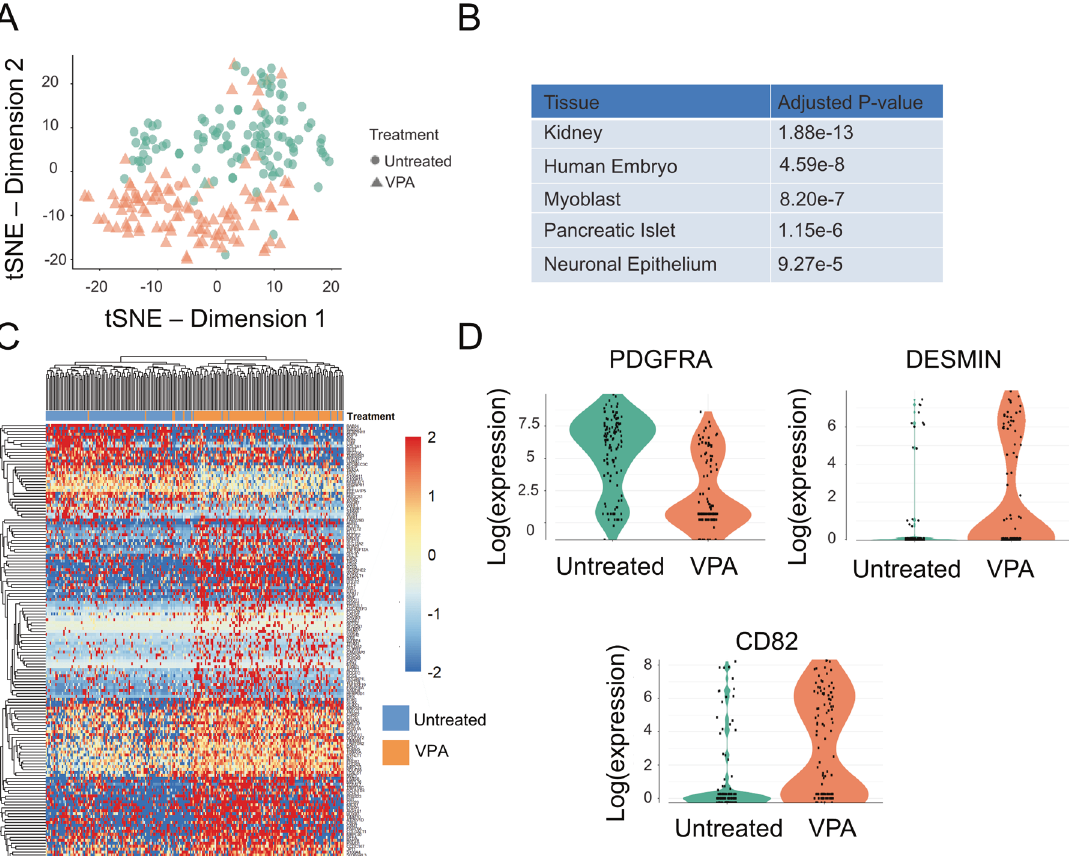
Fig. 8 Single-cell RNA sequencing reveals an upregulation of myogenic regulators after valproic acid treatment. A t-SNE plot colored by k - means clustering ( k = 2) of 227 cells either untreated (circles) or treated with valproic acid (VPA, triangles). B Top 5 ARCHS4 signi fi cantly enriched in the cluster corresponding to the VPA-treated cells. C Heatmap of k -means clusters with myogenic-related genes differentially expressed between untreated and VPA-treated mesodermal progenitors. D Expression of platelet-derived growth factor receptor A (PDGFRA), DESMIN and CD82 in untreated and VPA-treated mesodermal